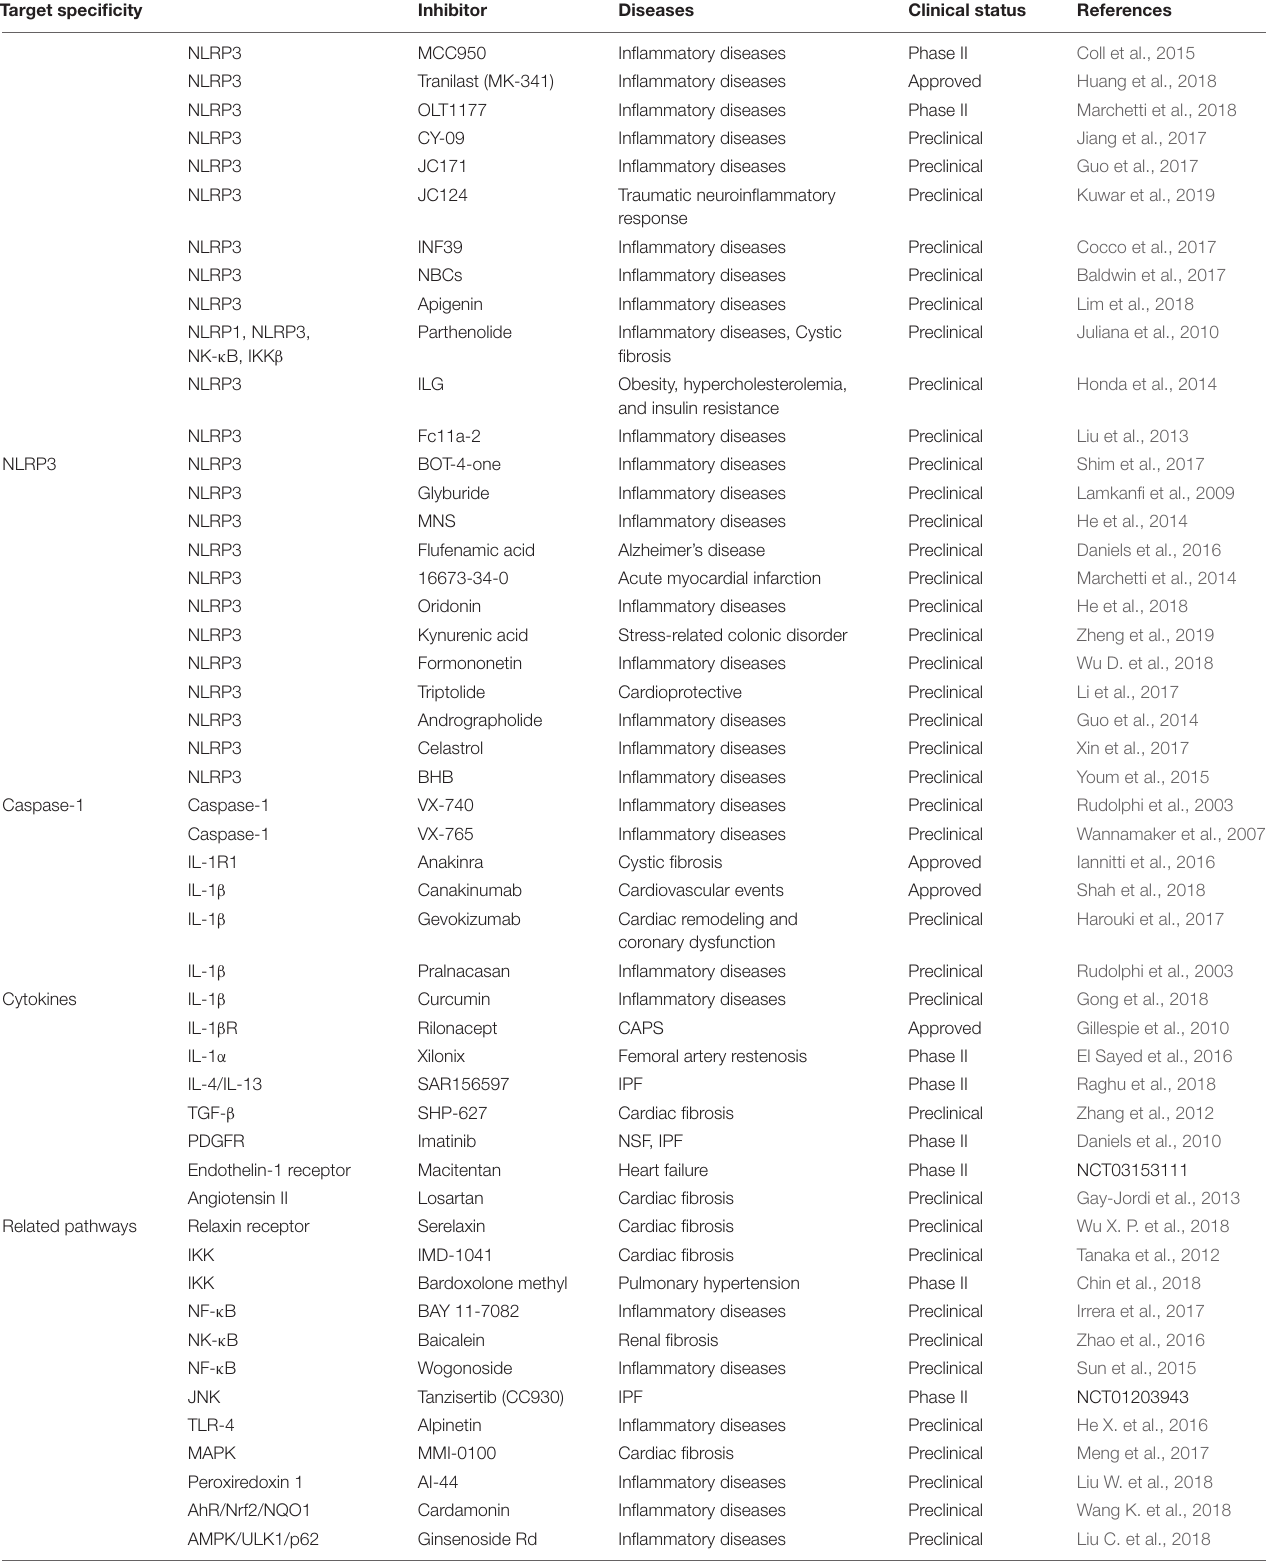
TABLE 1 | Inhibitors against NLRP3